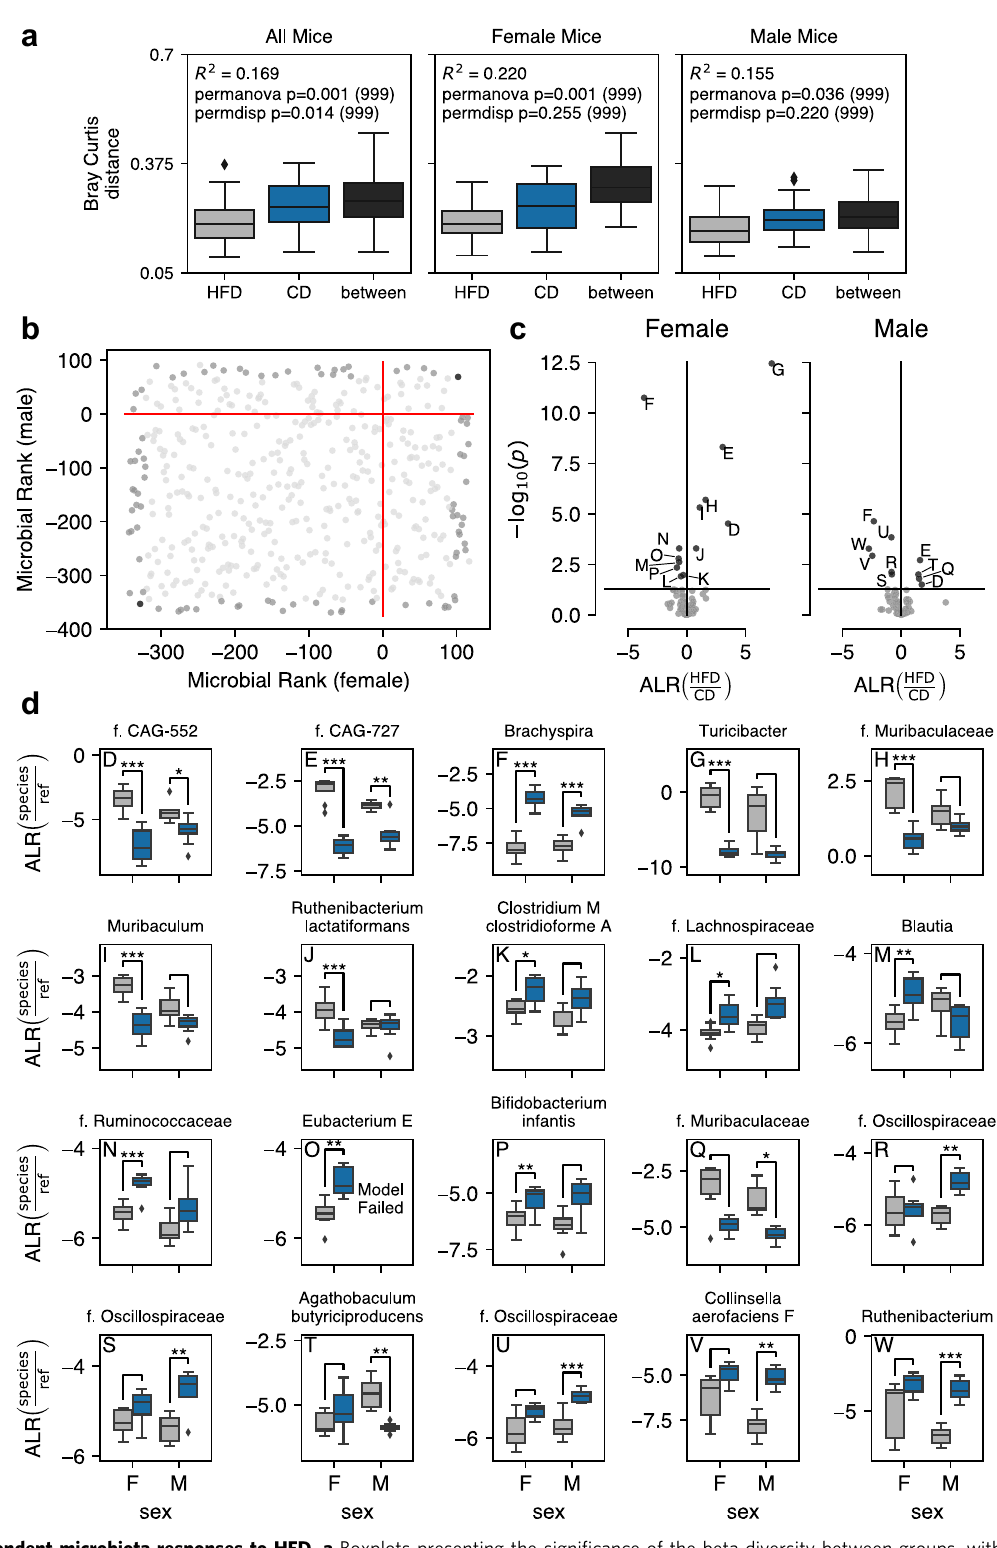
Fig. 2 Sex-dependent microbiota responses to HFD. a Boxplots presenting the signi fi cance of the beta diversity between groups, with Bray – Curtis distance. b Scatter plot of the microbial rank in males against the microbial rank in females upon HFD. The upper right corner indicates the top-ranked species in both sexes. c Volcano plots show the signi fi cantly altered species by HFD in females and males, respectively. d Boxplots of the additive-log-ratio transformed taxa showing the signi fi cantly altered species by HFD (blue) in females and males. The boxplots are shown as median (line), interquartile range (box), and minimum to maximum data range (whisker). * FDR < 0.05, ** FDR < 0.01, *** FDR < 0.001 (Benjamini –